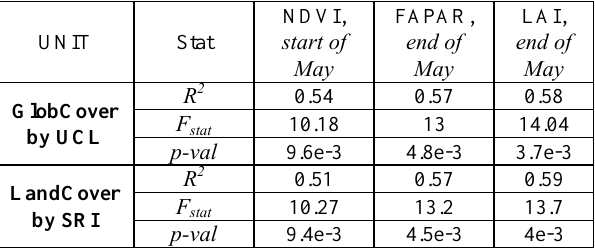
Table 3. Efficiency analysis of different crop masks for winter